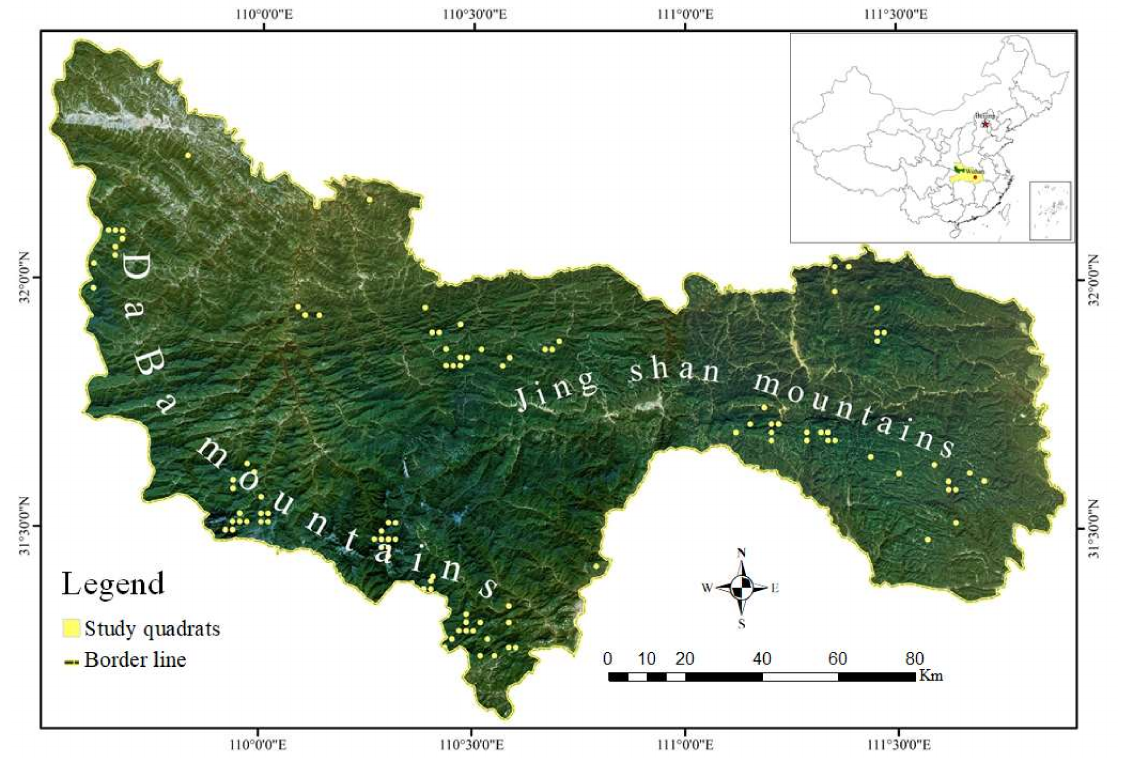
Figure 2. Study area. The yellow line indicates the border of the Daba-Jingshan mountain ranges in Hubei Province of China. Yellow circles indicate the sampled quadrats in the subtropical evergreen- deciduous broad-leaved mixed forests. An inset map shows the location of the study area within a map of the administrative boundaries of